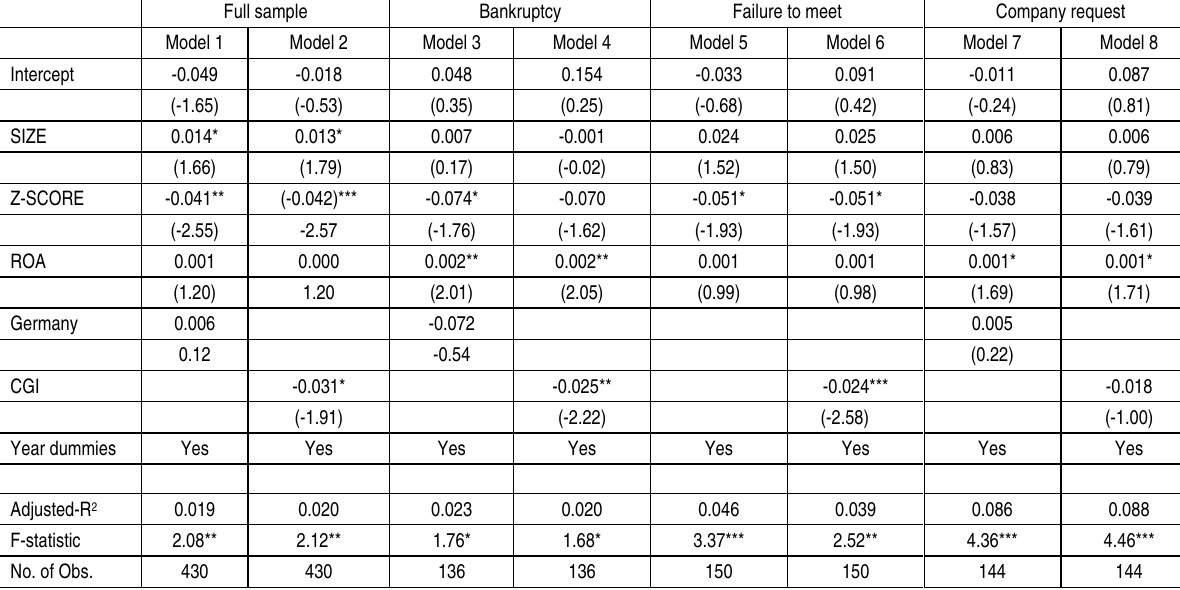
Table 8. Cross-sectional regression